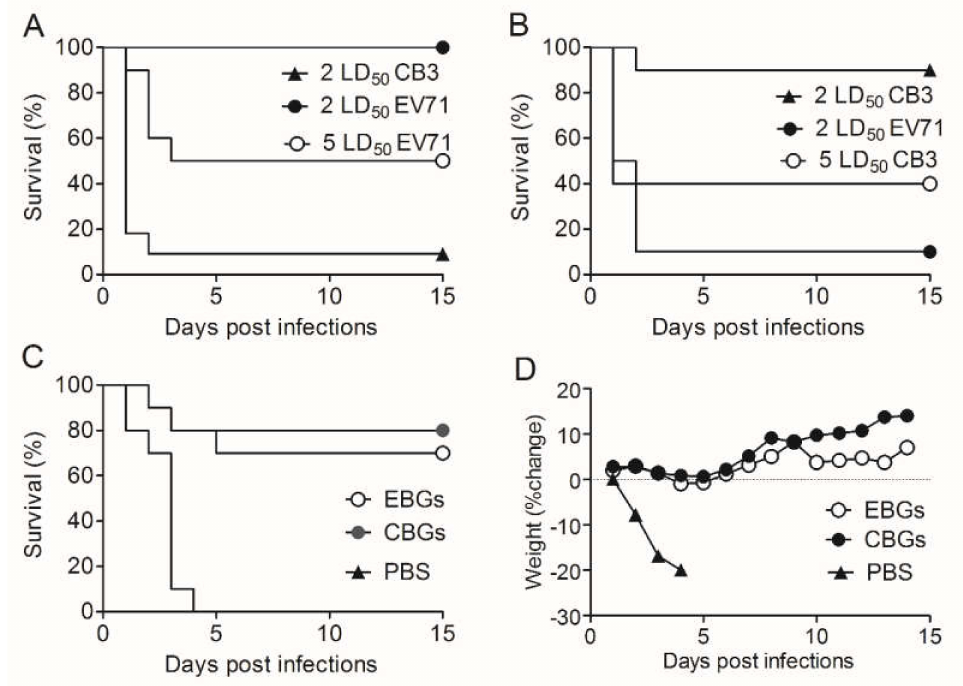
Figure 5. Vaccine candidates protected mice against a lethal dose of toxins. ( A ) Survival rates of the pups of mice immunized with BGs and challenged with 2 LD 50 CB3, 2 LD 50 EV71, or 5 LD 50 EV71. In comparison with mice immunized with PBS, all vaccine candidates increased the survival rate ( p < 0.001; n = 20 mice / group). ( B ) Survival rates for the pups of mice immunized with BGs and challenged with 2 LD 50 EV71, 2 LD 50 CB3, or 5 LD 50 CB3. In comparison with mice immunized with PBS, all vaccine candidates increased the survival rate ( p < 0.001; n = 20 mice / group). ( C ) Survival rate ( D ) body weight changes for wild-type mice immunized with BGs and challenged with 20 LD 50 (2 × 10 9 CFU) of viable E. coli O157:H788321 strain. In comparison with mice immunized with PBS, all vaccine candidates increased the survival rate ( p < 0.001; n = 20 mice / group). Similar results were observed in two independent experiments. Survival data were analyzed by log-rank tests. Data are from two independent